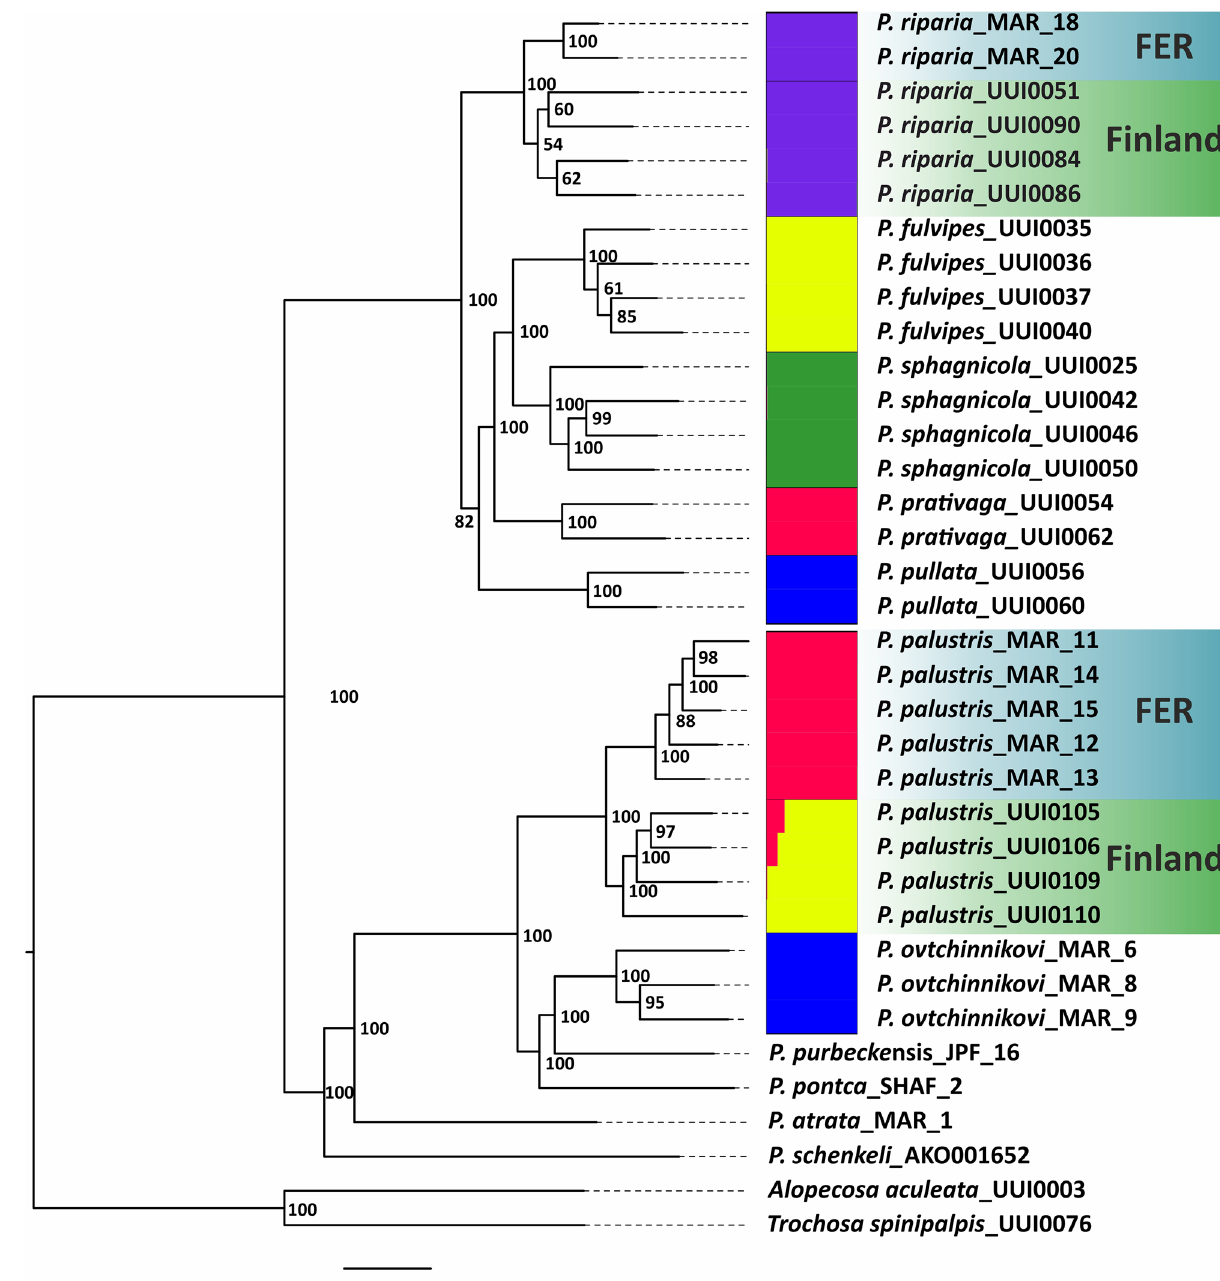
Figure 3. Maximum likelihood tree (Rip_pal_m6c85 dataset) and STRU CTU RE barplots (Rip_m10c85 and Pal_mon_m10c85 datasets) based on ddRADseq data. Numbers indicate bootstrap support values for nodes. STRU CTU RE barplots represent the patition with highest K supported where K = 5 for pullata group and K = 3 for monticola